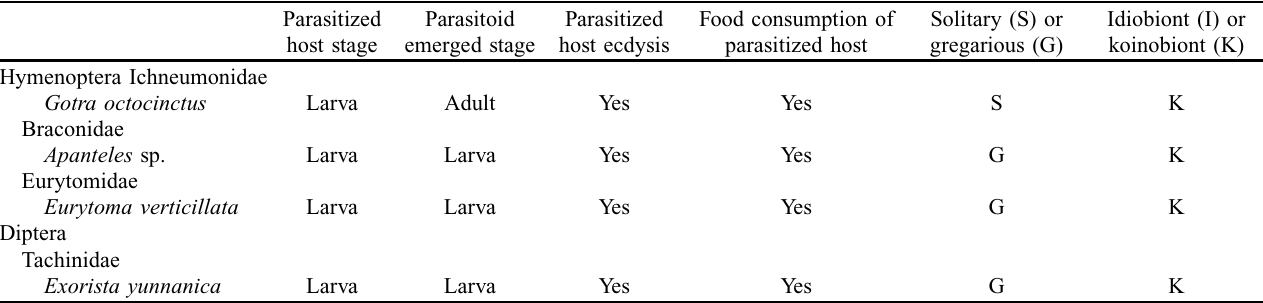
Table 2. Ecological characteristics of parasitoids in Phauda flammans larvae.